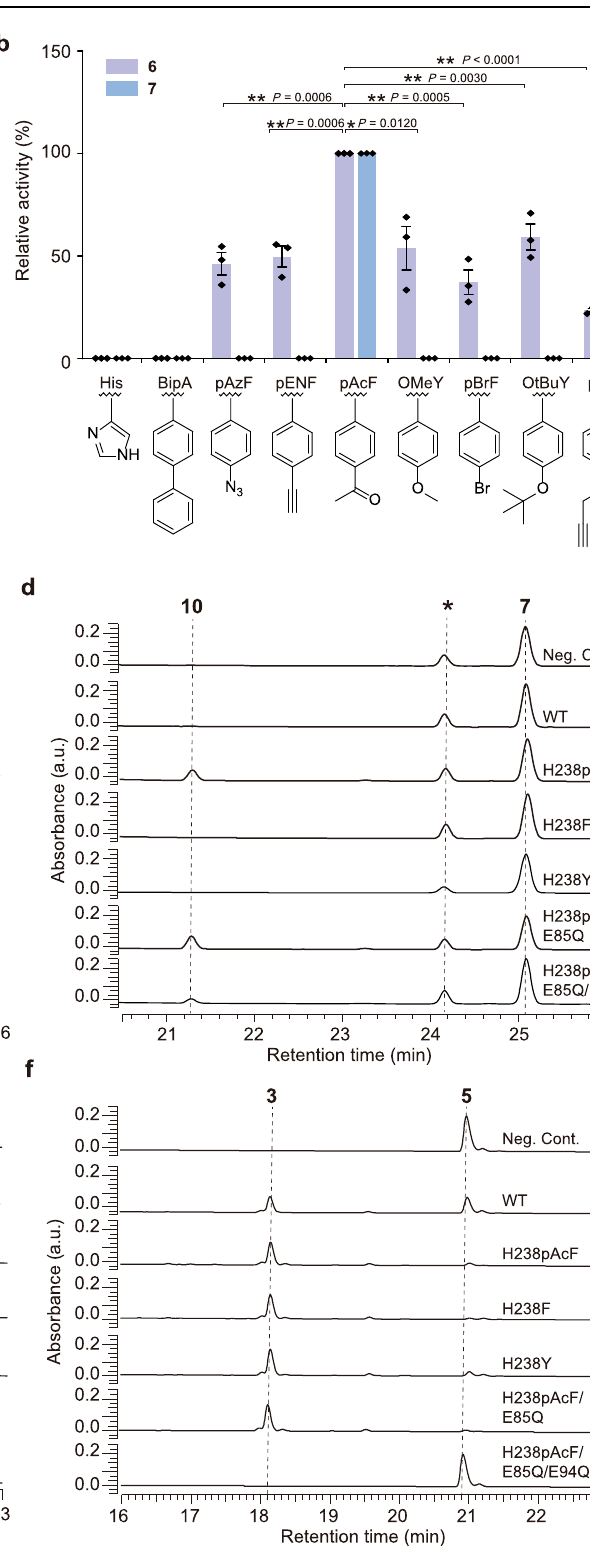
catalyzed by the wild type (WT) and indicated mutant PikC enzymes using 6 ( c ), 7 ( d ), 4 ( e ), and 5 ( f ) as substrates. Each individual in vitro enzymatic reaction con- taining 1 µ M PikC (wild type or mutant), 1mM NADPH, 10 µ M Fdx1499, 5 µ M FdR0978,and0.5mMsubstratein100 μ Lstoragebufferwasincubatedat30°Cfor 40min. The peaks marked by asterisk in ( d ) denote the spontaneous decomposi- tion product of 7 .